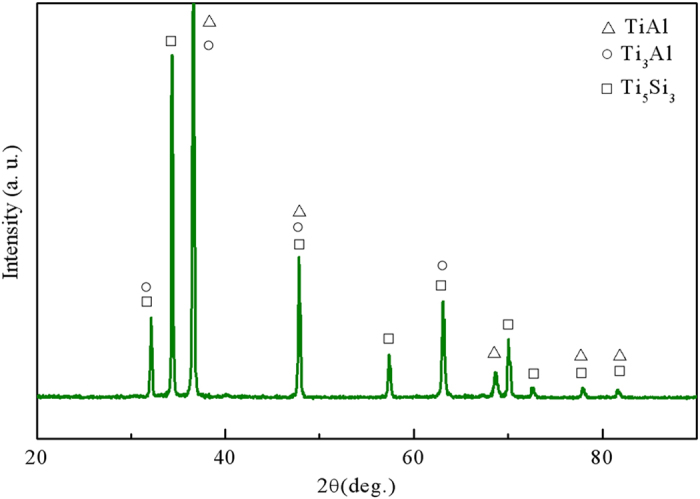
X-ray diffraction pattern of a directionally solidified Ti-43Al-3Si (at.%) alloy, revealing the existence of γ-TiAl, α2-Ti3Al and ξ-Ti5Si3 phases.